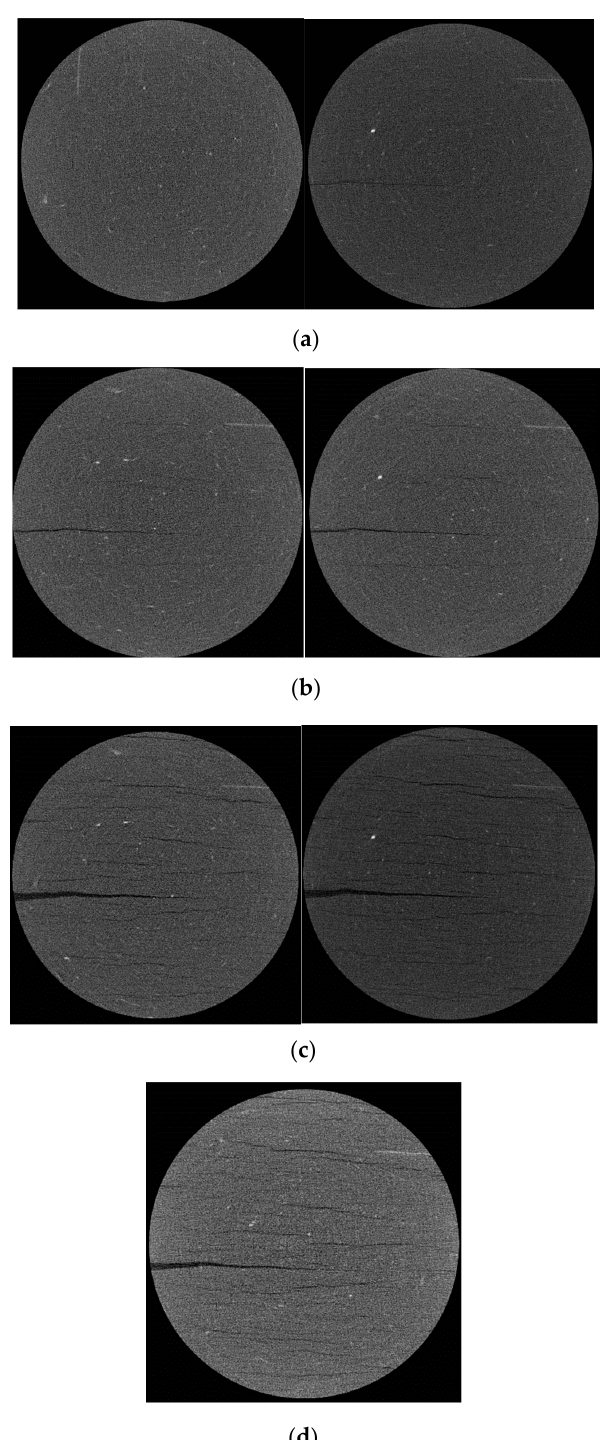
Figure 2. Experimental equipment: ( a ) X ‐ ray Micro ‐ Tomography system (model: μ CT225kVFCB) from Taiyuan University of Technology; ( b ) Quantachrome 33 from Quantachrome Instruments.